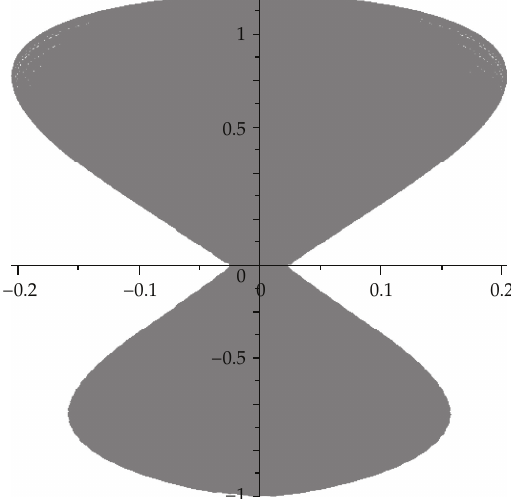
Figure 1: V (cid:2) T (cid:3) for p (cid:4)